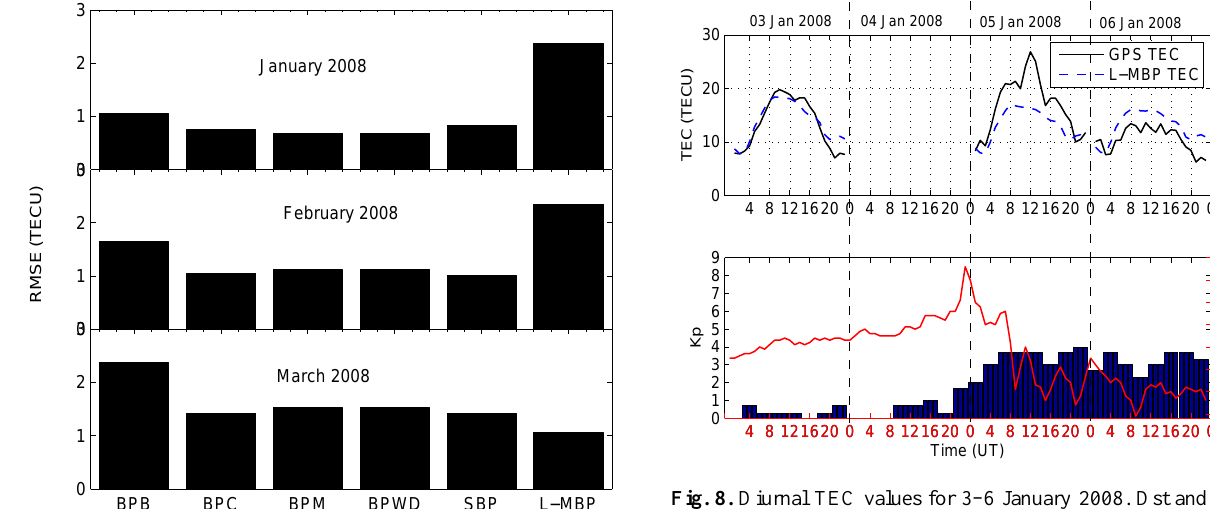
Fig. 8. Diurnal TEC values for 3–6 January 2008. Dst and Kp in- dices for this period are also